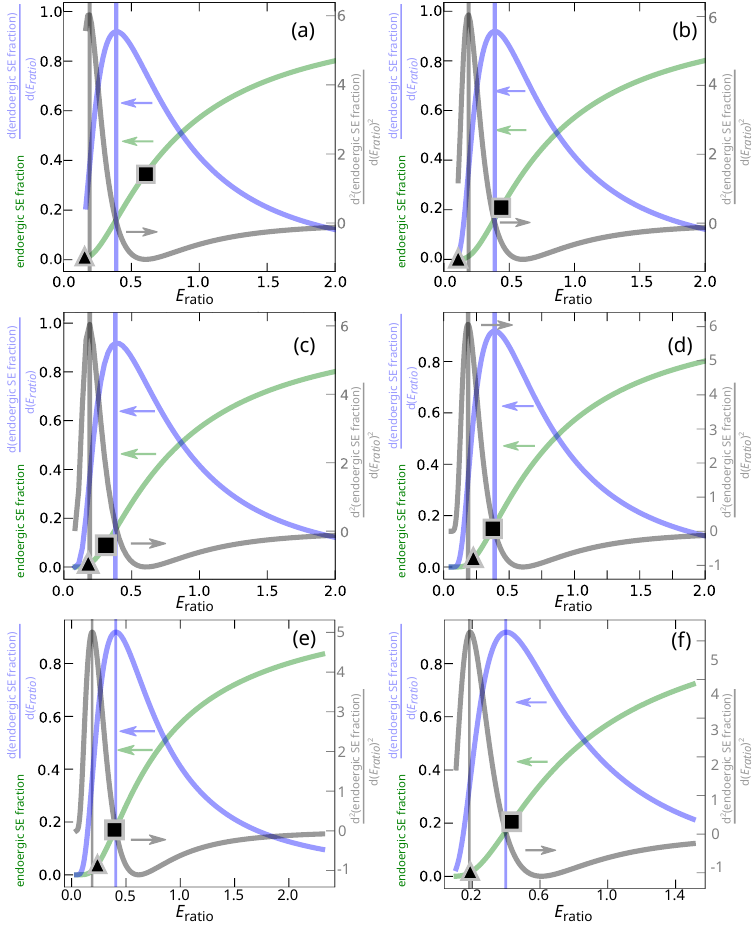
Figure 8: Endoergic SE fraction along the direction of constant energy for dif- / k = 0.7 (cid:181) K, (b) 1.1 (cid:181) K, (c) 1.3 (cid:181) K, (d) 1.6 (cid:181) K, (e) 1.91 (cid:181) K and ferent E . (a) E tot tot B (f) 2.2 (cid:181) K. The green line represents the fit function of the endoergic fraction along the constant energy axis calculated by Eq. 3. Blue and dark lines show the first and second derivatives of the fit function. The maximum sensitivity for the left (right) side of the d is illustrated as black squares and triangles, as in Fig. 2. The vertical Bures lines mark the maxima of the